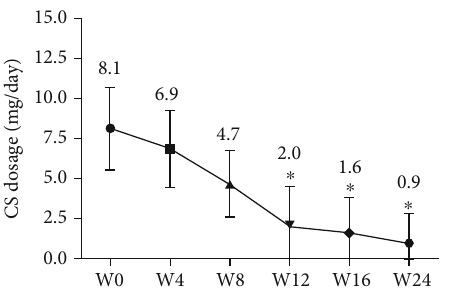
Figure 3: Change of the mean daily CS dose (prednisone equivalent) during the 24 weeks after tofacitinib treatment is initiated. Abbreviations: CS: corticosteroid. ∗ p < 0 : 05 versus CS dosage at baseline (week 0). Data was represented as mean ± SD . ∗ p < 0 : 05 versus week